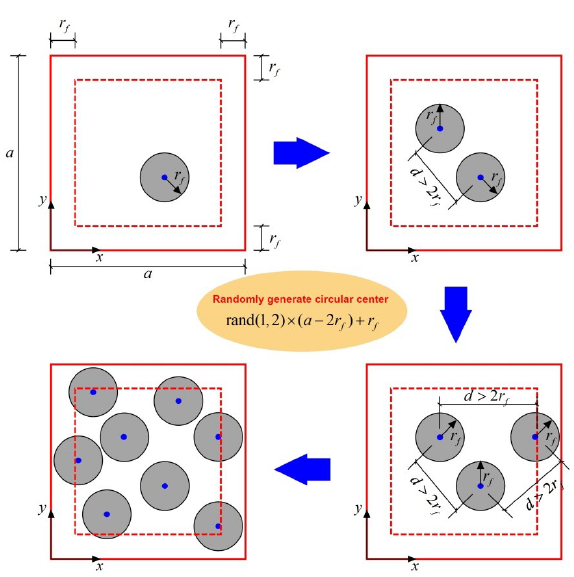
Figure 1: Schematic illustration of the procedure of the present